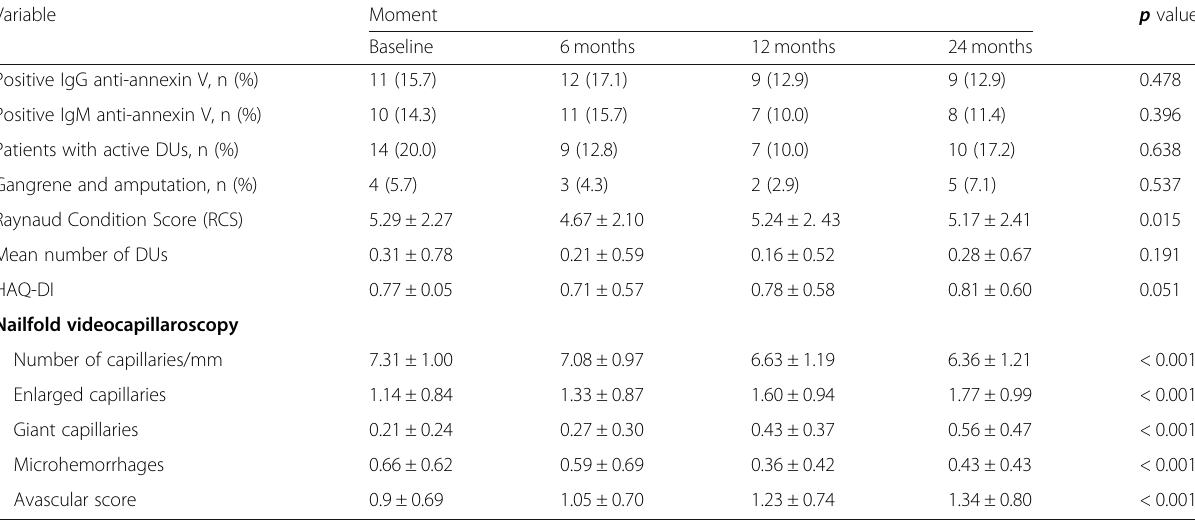
Table 2 Longitudinal data of anti-annexin V serum levels, severity of Raynaud ’ s phenomenon, HAQ-DI and nailfold capillaroscopy of the 70 SSc